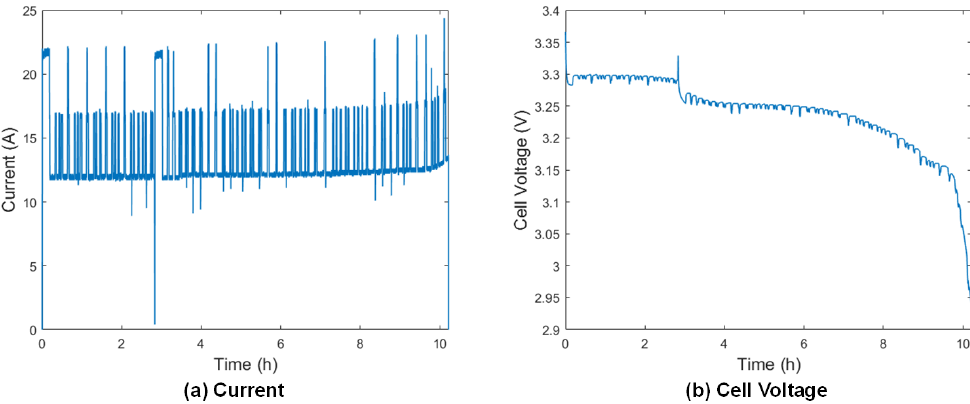
Figure 8. The current and the voltage of the 1st cell while ESS is running: ( a ) Current. ( b ) The voltage of the 1st cell .